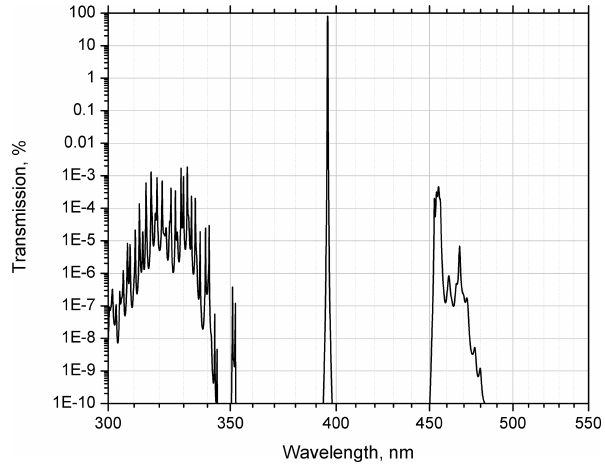
Figure 1. Simulated transmission curve of the methane filter pro- vided by Alluxa.